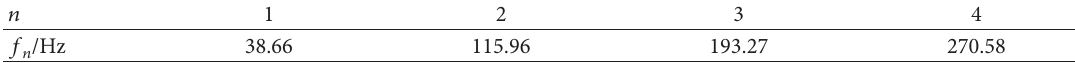
Table 3: Normal mode frequencies in the waveguide.